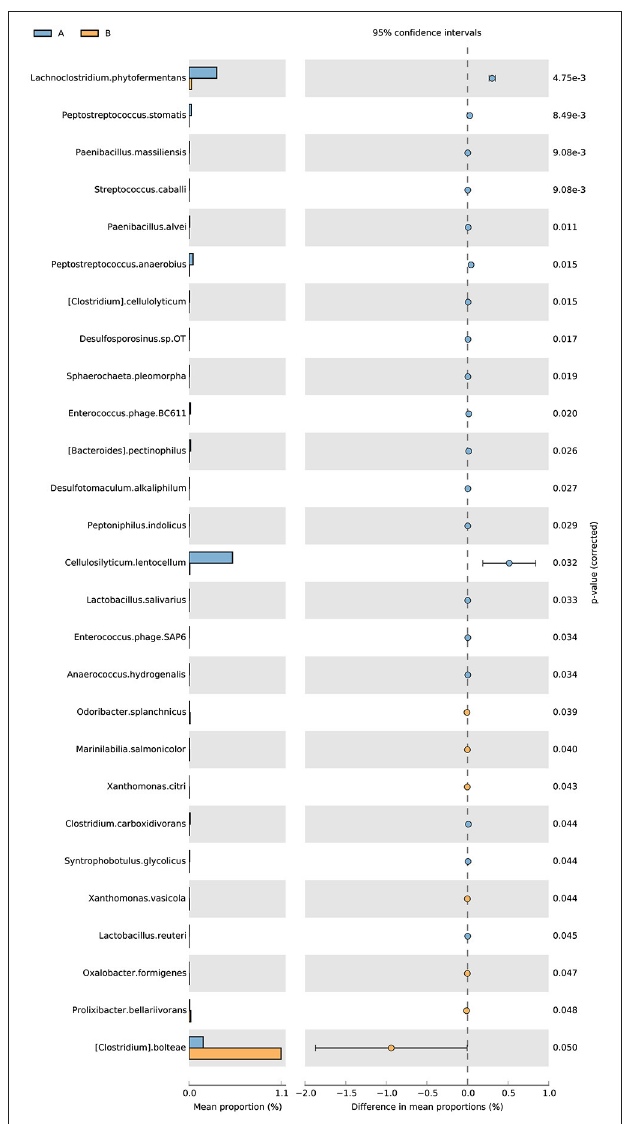
FIGURE 7 | Metagenomic profile comparisons of differentially abundant species between the group A and B samples using STAMP analysis. A positive difference between proportions denotes a greater abundance in group A (orange), whereas a negative difference between proportions shows a greater abundance in group B (orange) for the given gene. Corrected P -values ( q -values) were calculated based on G Test (w + Yates) + Fisher’s statistical test using Story’s FDR approach. Features with q < 0.05 were considered significant and were thus